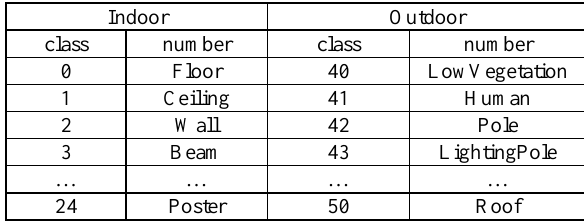
Table 2. An extract from the list of established classes.